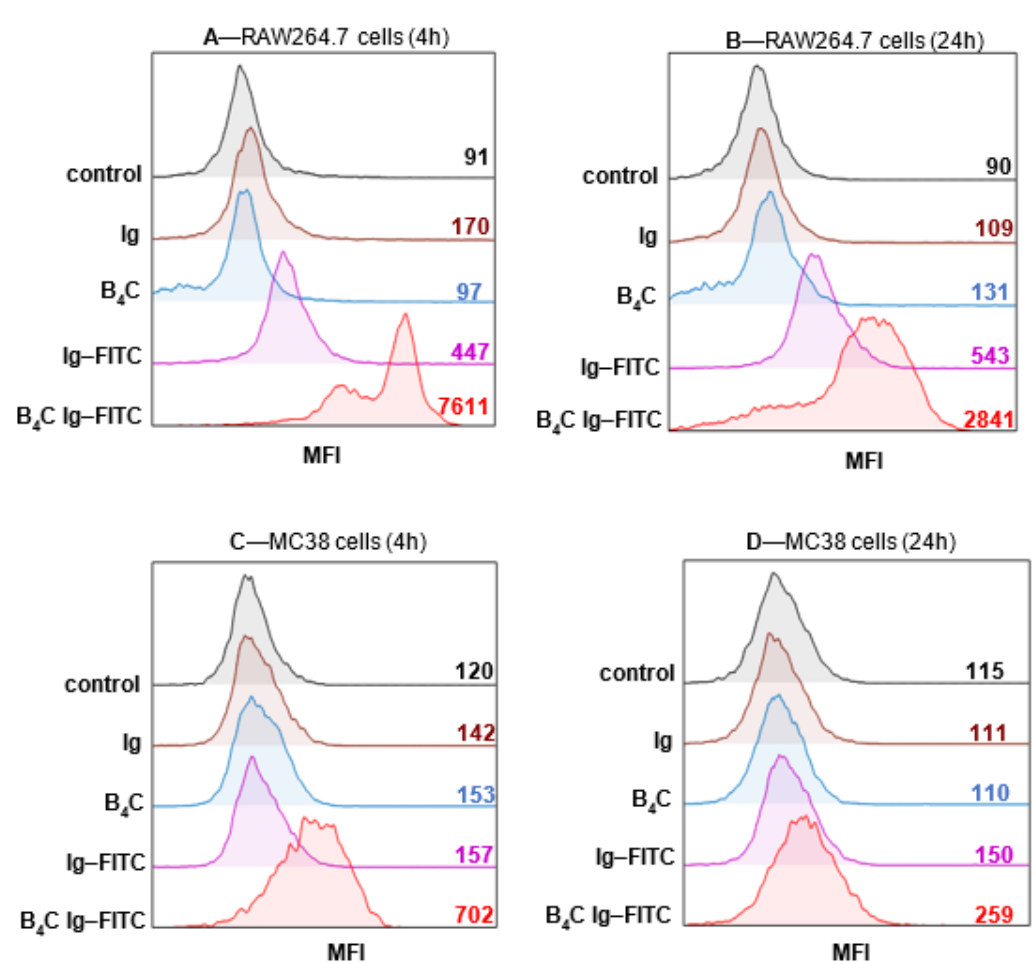
Figure 7. Evaluation of the interaction level of boron carbide nanoparticles with myeloid and cancer cells. Mean fluorescence intensity (MFI) was analyzed using flow cytometry after 4 and 24 h of exposure of RAW264.7 ( A , B ) and MC38/0 cells ( C , D ) on the labeled carrier. IgG, human immunoglobulin; IgG–FITC, fluorescein-labeled IgG; B 4 C, boron carbide nanoparticles; B 4 C Ig–FITC, boron carbide nanoparticles functionalized with human FITC-labeled IgG.